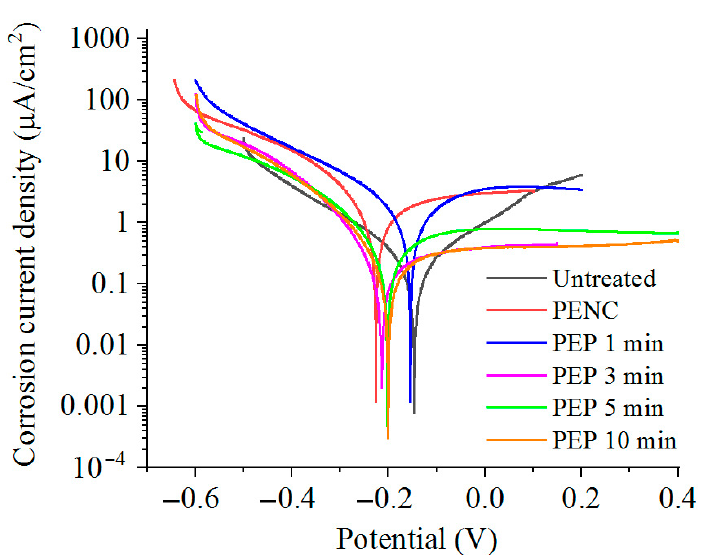
Figure 7. Potentiodynamic polarization curves of the CP-Ti samples before and after anodic PENC at 900 °C and subsequent PEP in a solution of ammonium sulfate (3%) at 300 V for different time.